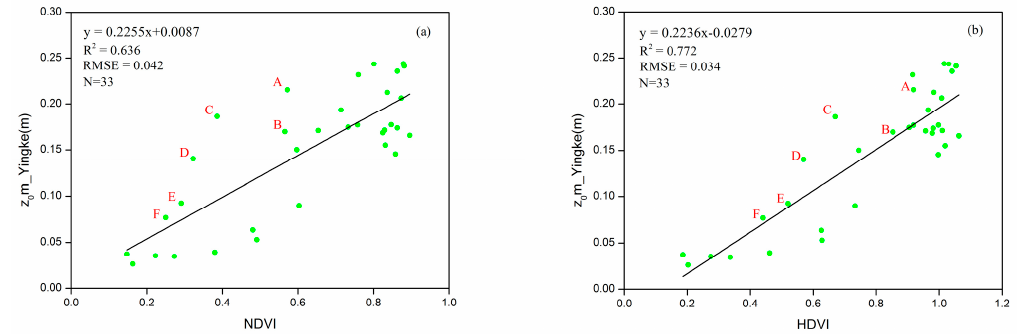
Figure 6. Observed aerodynamic roughness length as functions of: ( a ) NDVI; and ( b ) HDVI. The data were collected during the growth period of spring maize (April to October) in 2014 at the Yingke site. Points A–F represent the values for October 1, 6, 11, 16, 21 and 26, respectively.